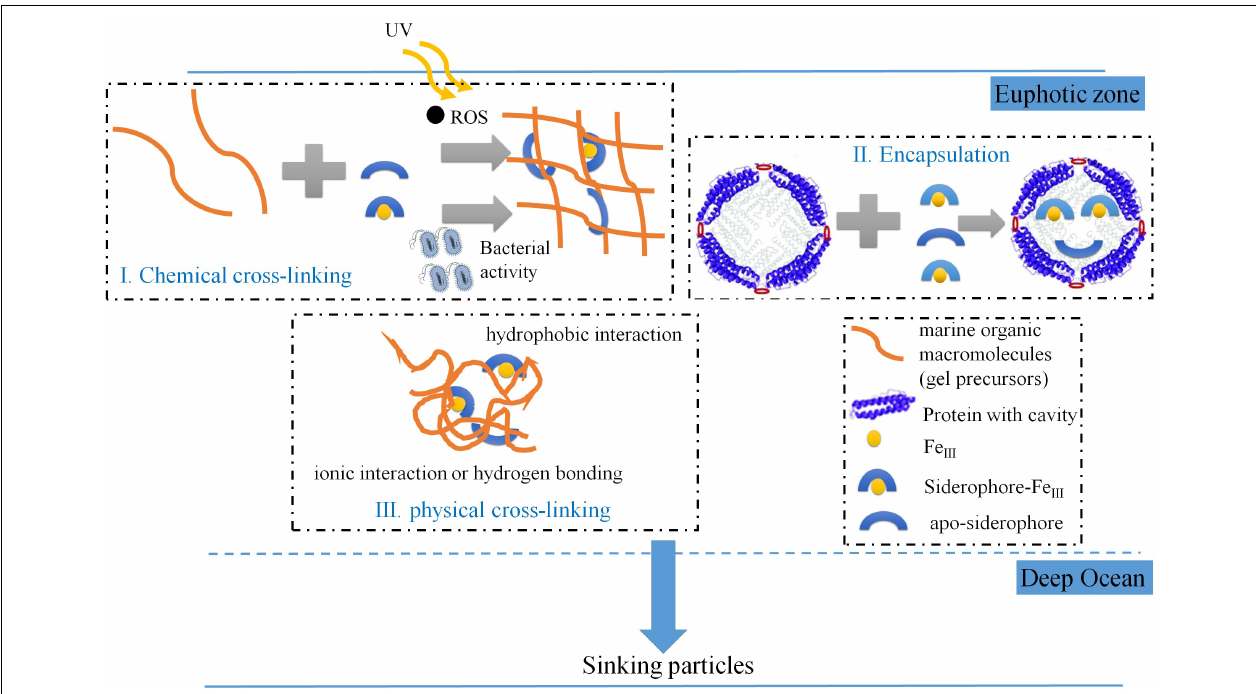
FIGURE 7 | Conceptual scheme showing the possible mechanisms for hydroxamate-like moieties incorporation into marine settling particle.